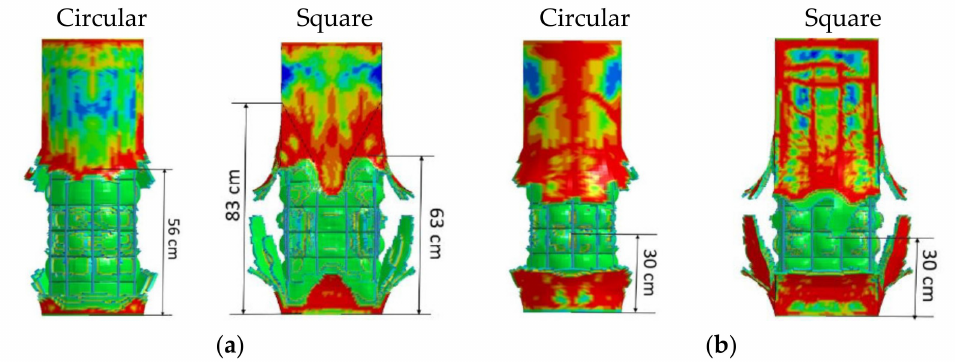
Figure 21. Comparison of damages of circular and square RC columns after the detonation of 1 kg of TNT: ( a ) front side and ( b ) back side [23]. Copyright permission obtained from authors.